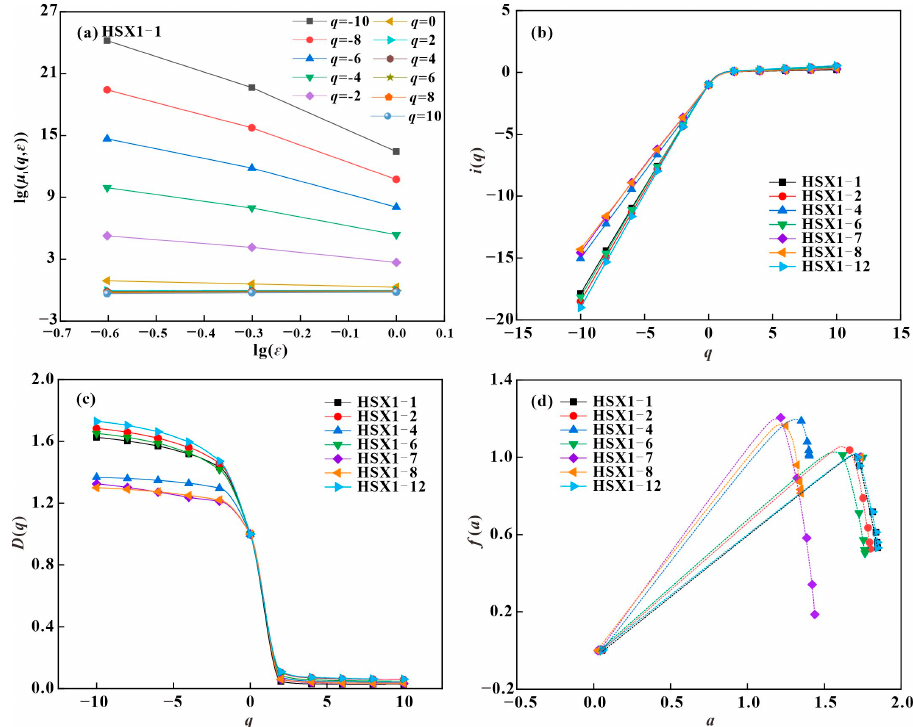
Figure 8. Multifractal analysis of N 2 adsorption: ( a ) The log–log plot of the partition function versus the box scale. ( b ) The relationship between the mass scaling function and the statistical moment order of all samples. ( c ) The generalized fractal dimension spectra of all samples. ( d ) The multifractal singularity spectra of all samples .